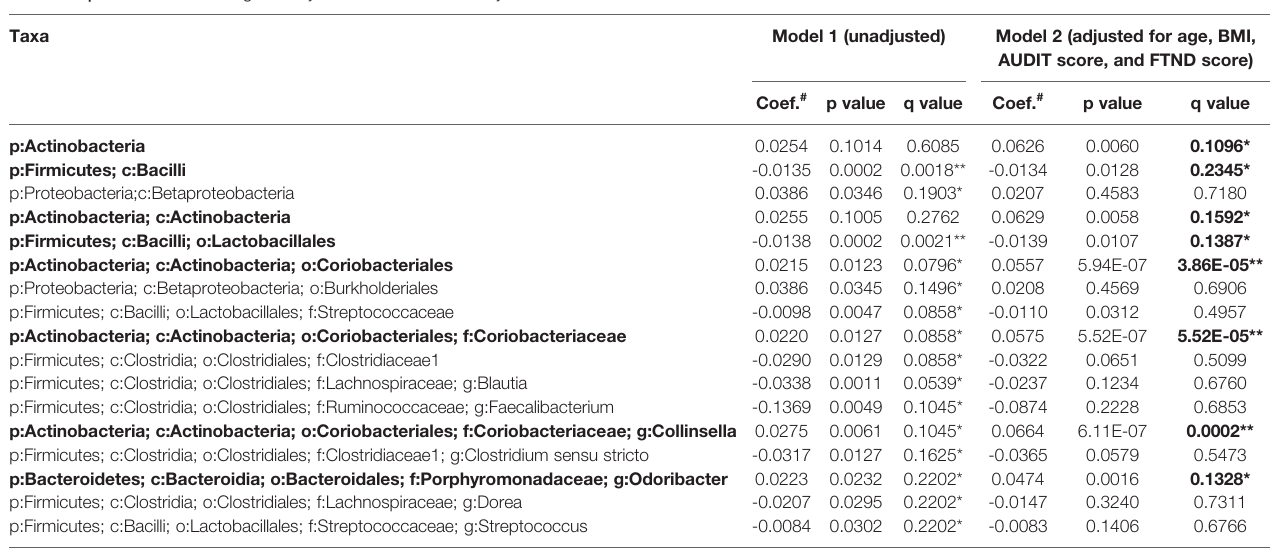
TABLE 2 | Detection of taxa signi fi cantly associated with MUD by MaAsLin2. Taxa Model 1 (unadjusted) Model 2 (adjusted for age, BMI,